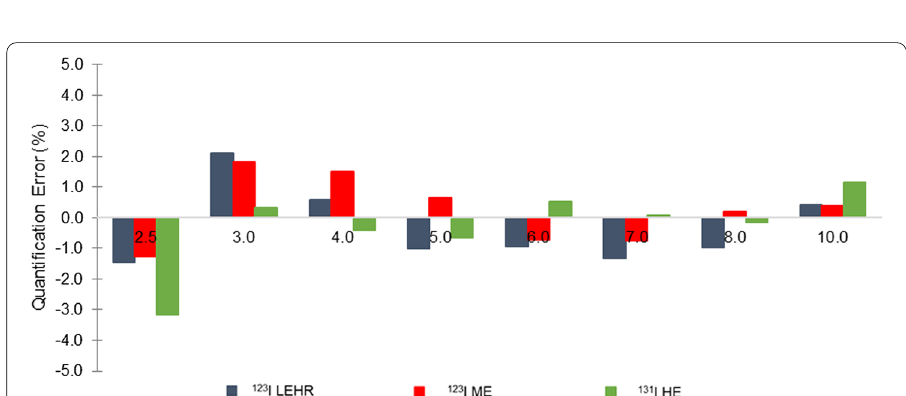
Fig. 6 Quantification error (%) of spheres of differing diameter in a warm cylindrical phantom, for 123 I LEHR, 123 I ME and 131 I